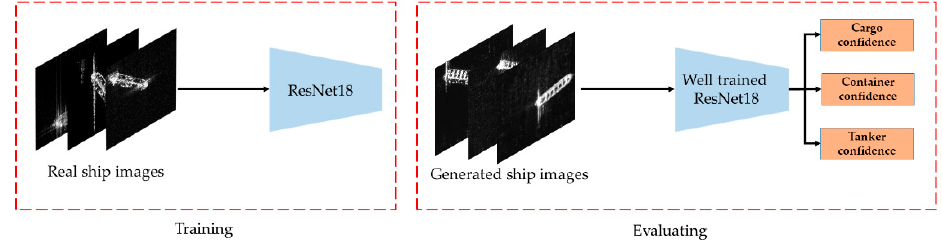
Figure 7. The Generative Adversarial Networks (GAN) test evaluation method based on ResNet18 network.